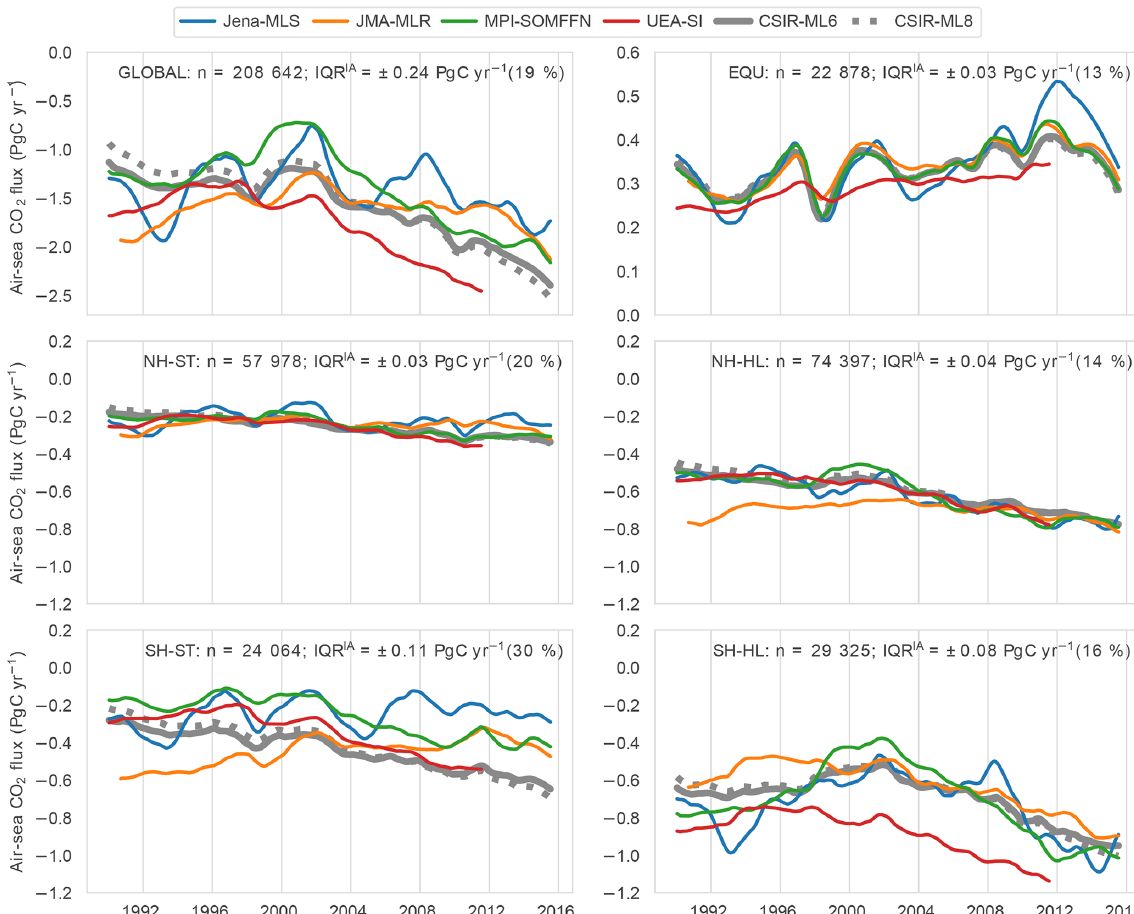
Figure 10. Sea-air CO 2 fluxes averaged for regions as shown in Fig. 2: (a) global domain, (b) equatorial regions, (c) Northern Hemi- sphere subtropical, (d) Northern Hemisphere high latitude, (e) Southern Hemisphere subtropical. (f) Southern Hemisphere high latitude. The coloured lines show the four SOCOM products. The thick and dotted grey lines show the results for CSIR-ML6 and CSIR-ML8, respec- tively. A moving average of 12 months has been applied to smooth the data. Note that the y -axis scales differ for the top (a, b) . Note that the uncertainties of each model (e.g. bias and RMSE from Fig. 6) are not shown here. The text at the right of each figure shows the number of SOCAT v5 gridded data points for each region ( n ) and the interannual interquartile range (IQR IA